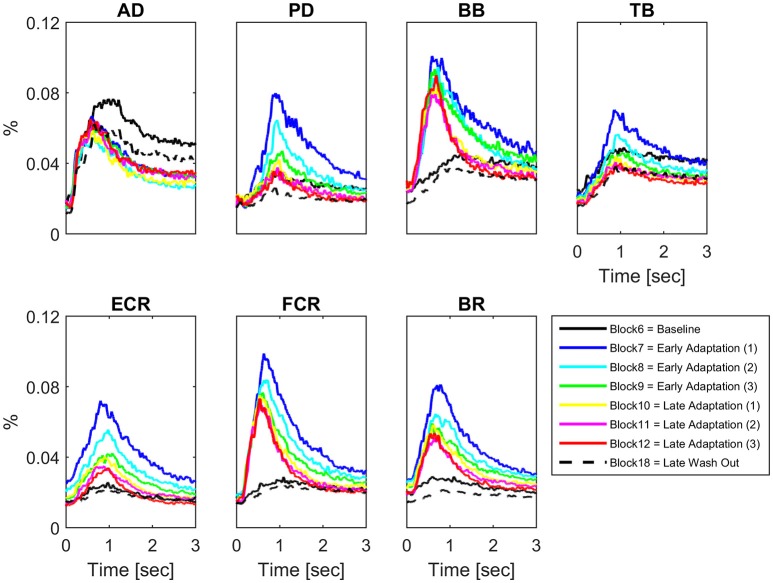
Block-by-block muscle-specific activation profiles. For each muscle block-by-block average (N = 16) activation profile (from visual cue to 3 s afterwards) have been color coded to describe the evolution of muscle-specific activation over the adaptation period. A clear pattern of adaptation to the clockwise force-field is present in Biceps Brachii and Flexor Carpi Radialis.